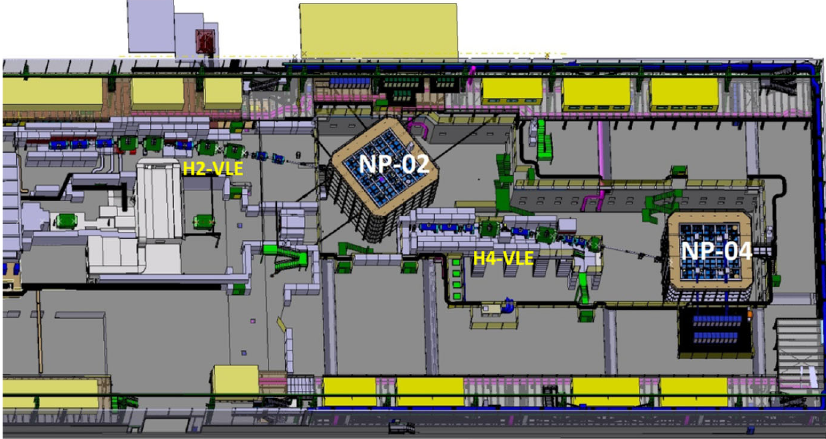
cryostat.FIG. 2. 3D drawing showing the layout of the EHN1 hall extension housing the two detector prototypes for the NP-02 and NP-04 experiments. The H2 and H4 beam line extensions reaching the two experiments respectively are also